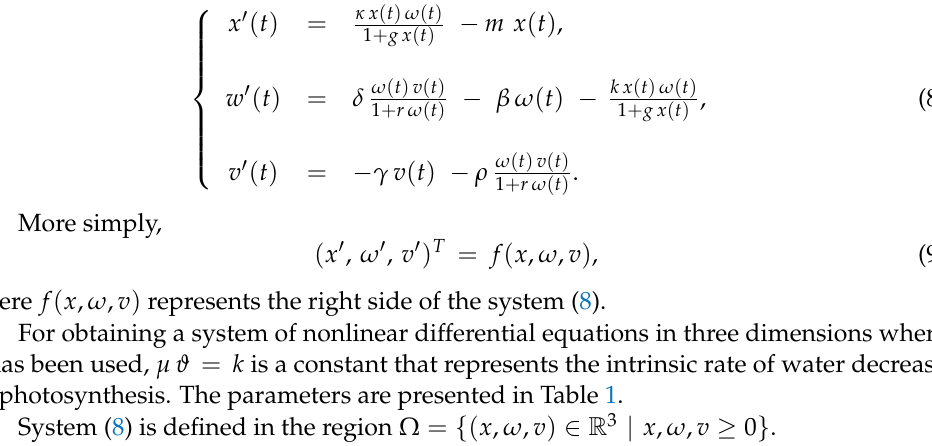
Table 1. Parameters considered in the present study. Parameters Meaning